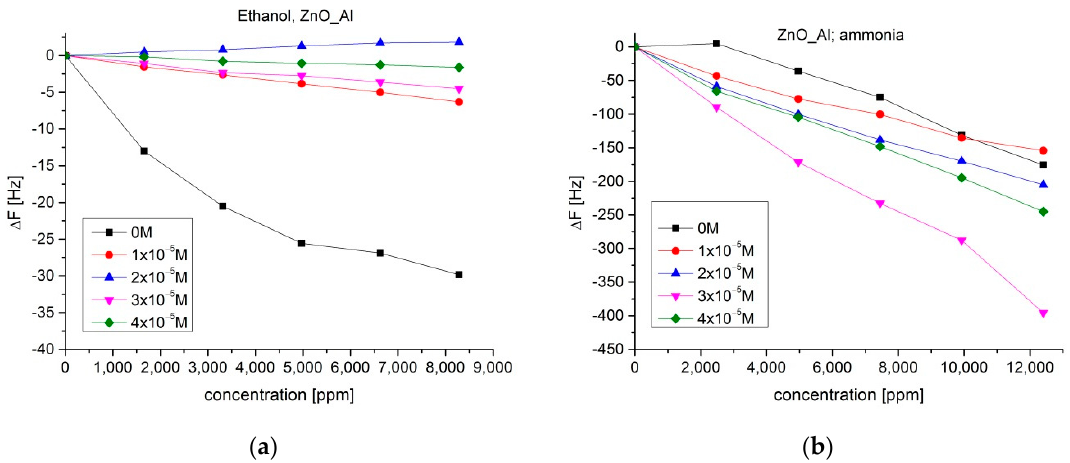
Figure 5. Sensitivity of the electrochemically deposited ZnO:Al layers on the quartz resonator electrode (deposited with different concentrations of Al 2 (SO 4 ) 3 to: ( a ) ethanol and ( b ) ammonia.